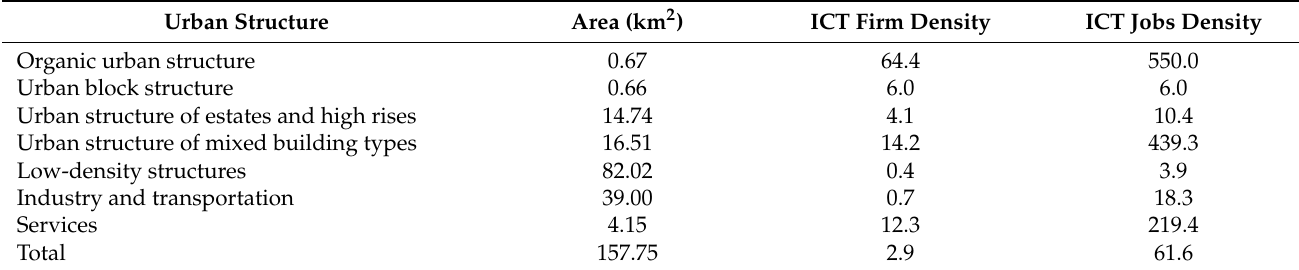
Table 3. ICT firms/jobs density and urban